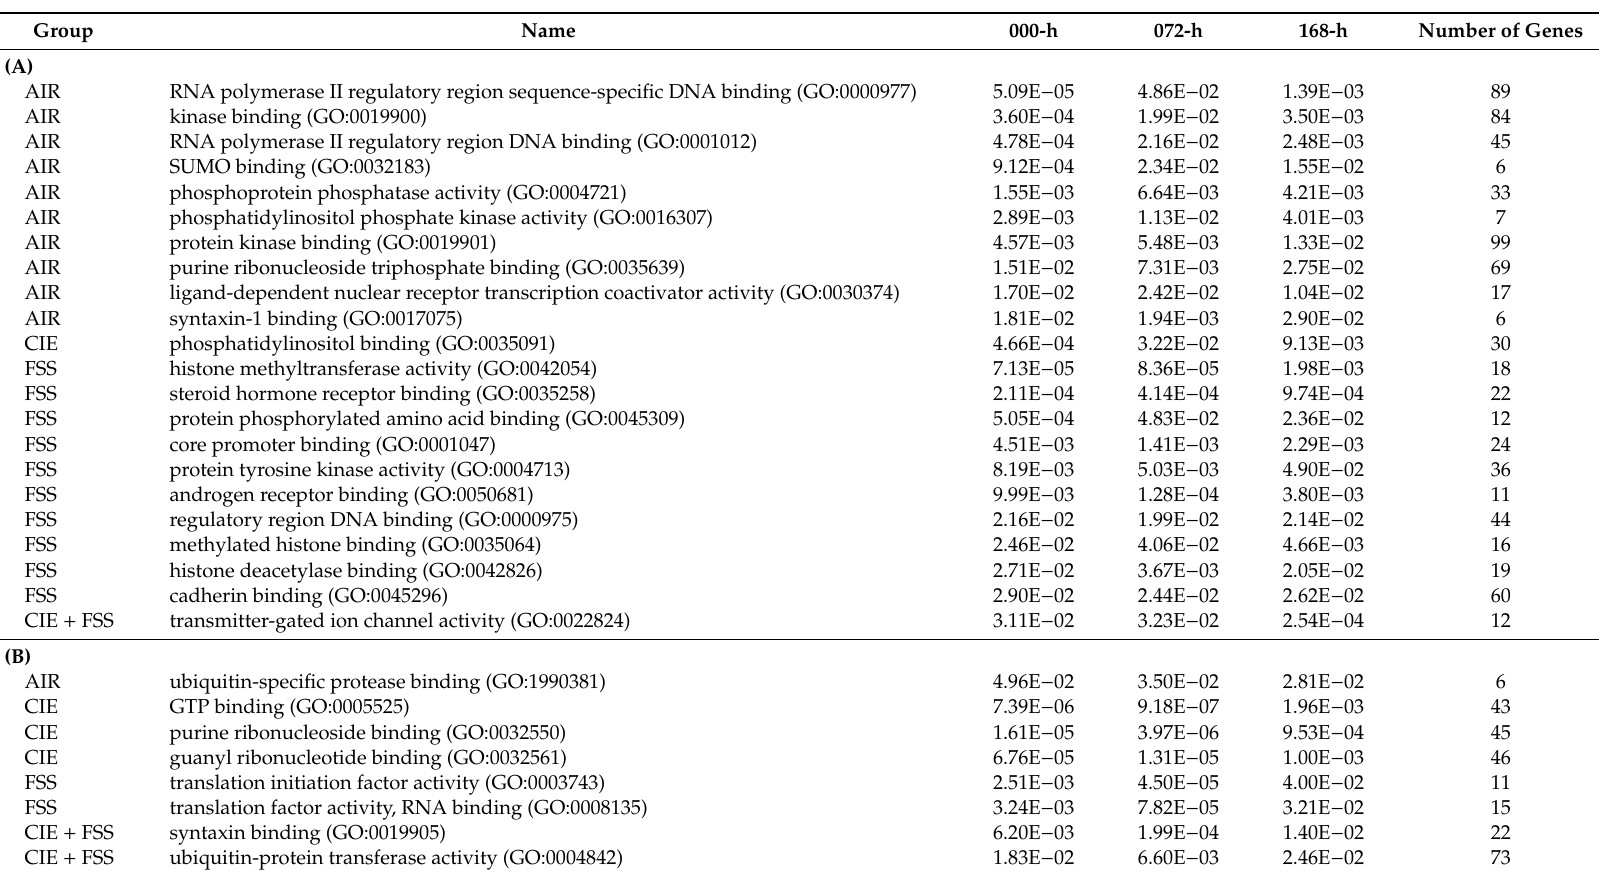
Table 1. Gene ontology analysis of molecular function for (A) increased and (B) decreased di ff erential gene expression, showing canonical groups that are consistently altered across time and uniquely regulated within each behavioral group (CTL, CIE, FSS, and CIE + FSS). The number of genes represent the union of significant genes in that behavioral group and canonical molecular function across time. Results are significantly overrepresented ( p < 0.05), uniquely with respect to an individual group and timepoint. CTL: non-dependent alcohol consumption, CIE: chronic intermittent ethanol, and FSS: forced stress swim.